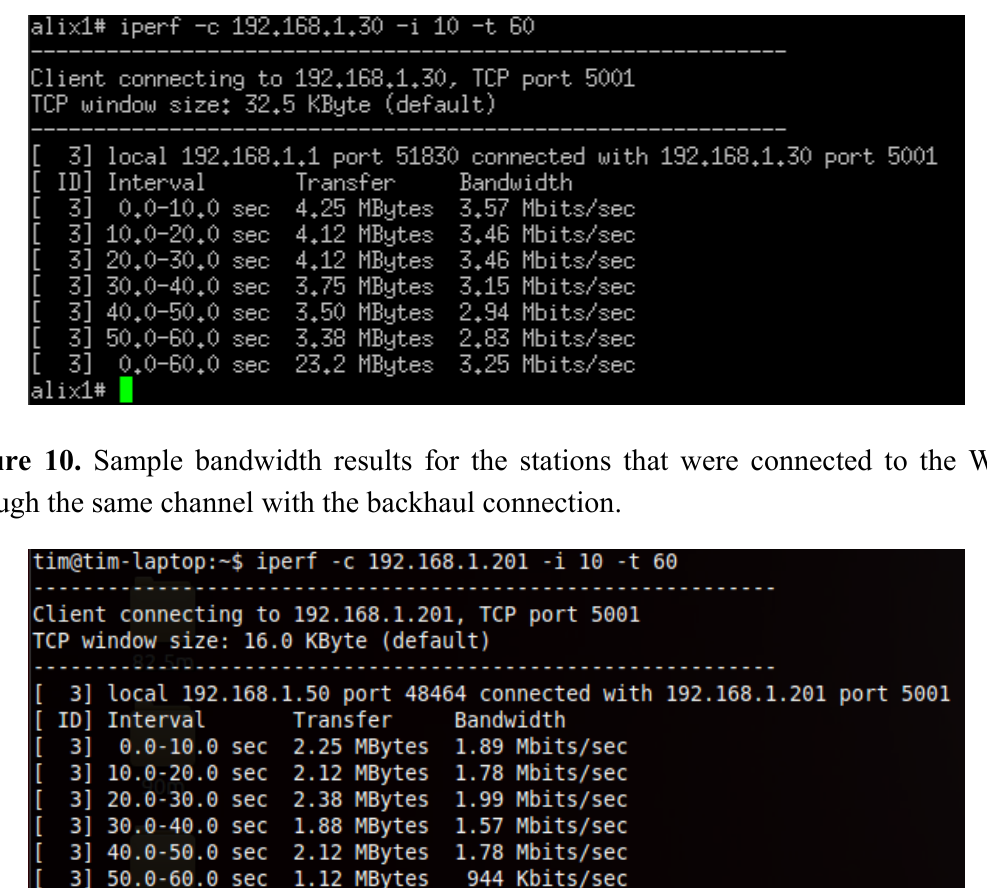
Figure 9. Sample bandwidth results of the MP1-MP3 connection.